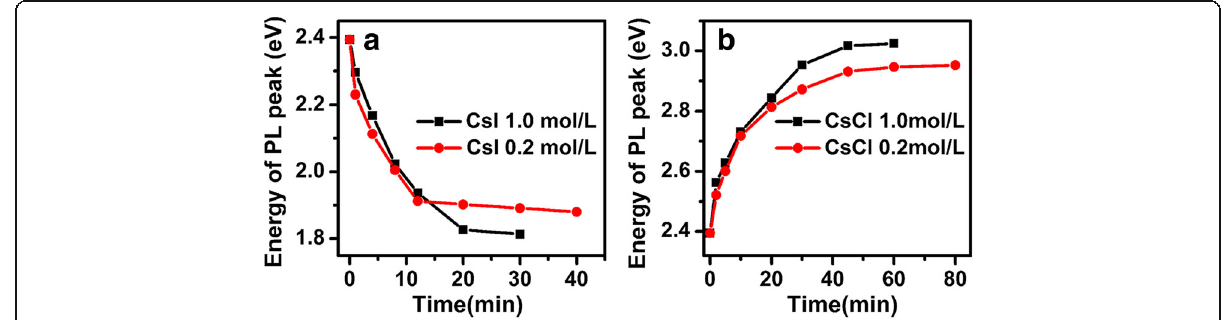
Fig. 4 Emission peak energies of CsPbX 3 NCs exchanged with 1.0 and 0.2 mol/L a CsI and b CsCl aqueous